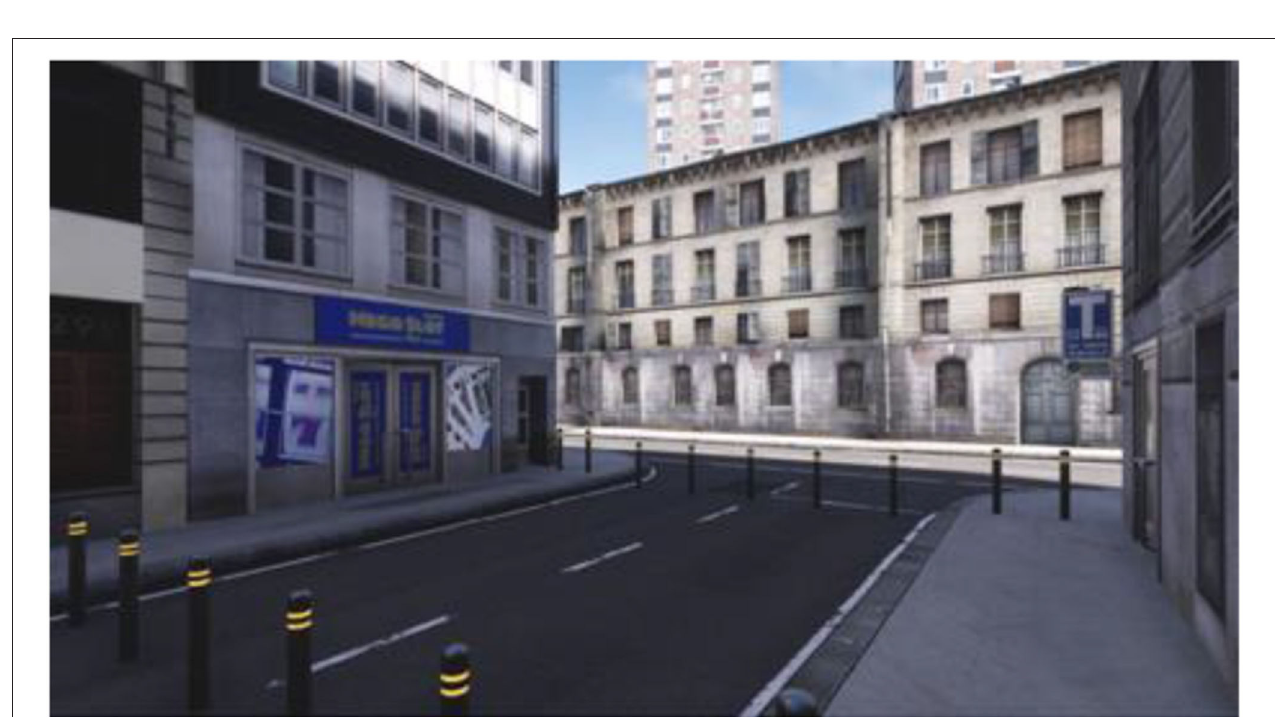
FIGURE 2 | A city street with access to a tobacco store and a slot